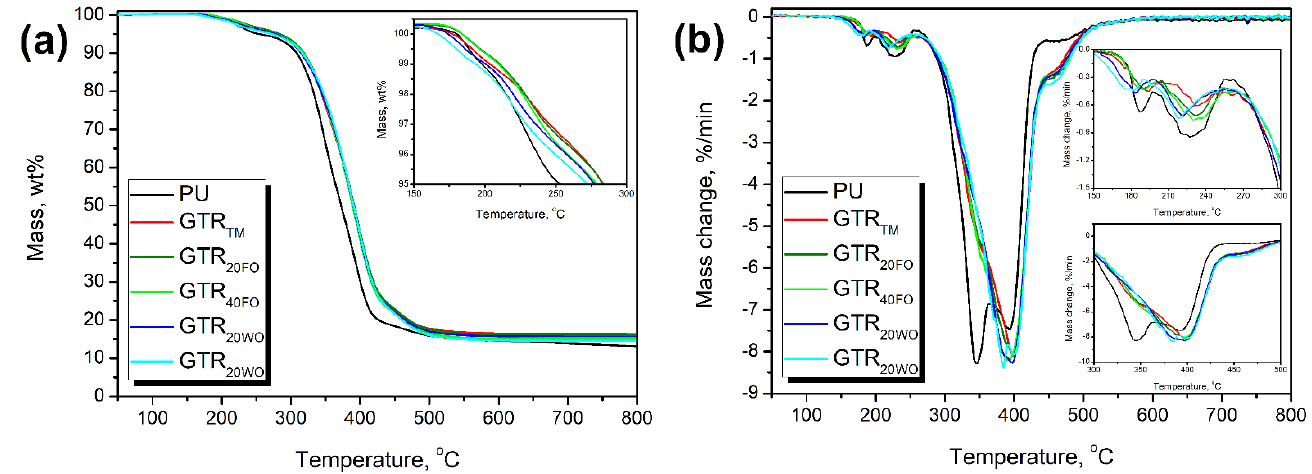
Figure 6. Temperature plots of ( a ) mass loss and ( b ) mass loss rate of prepared foams.